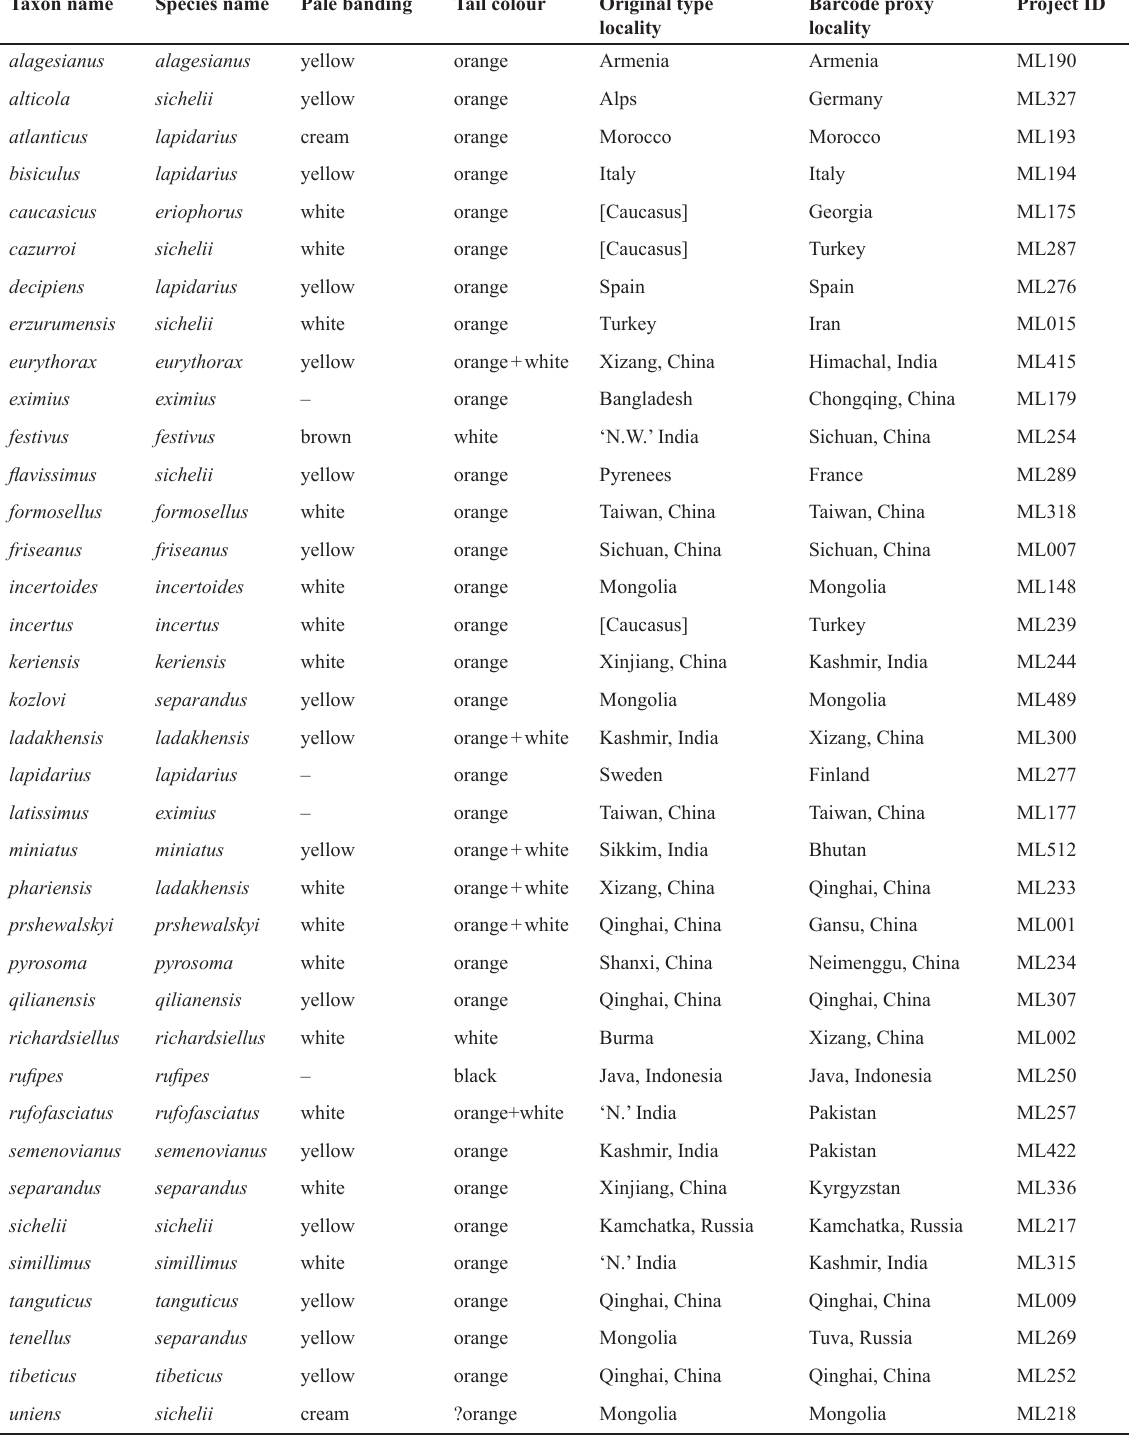
Table 3. List of selected available formal names in the species group for taxa of the subgenus Melanobombus von Dalla Torre, 1880 (for details of the references, see the text) . These names are associated informally with barcoded specimens as proxies for types. ‘Tail’ colour refers to the predominant colour of the pale hair on metasomal terga 4‒6 (T4‒6); project ID refers to the specimen number (ML n ) of the proxy type in the Melanobombus project